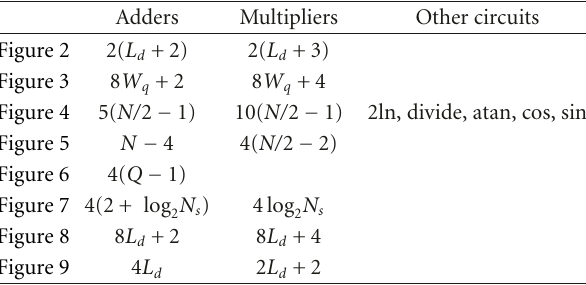
Table 1: Number of circuits for parallel realization. Adders Multipliers Other